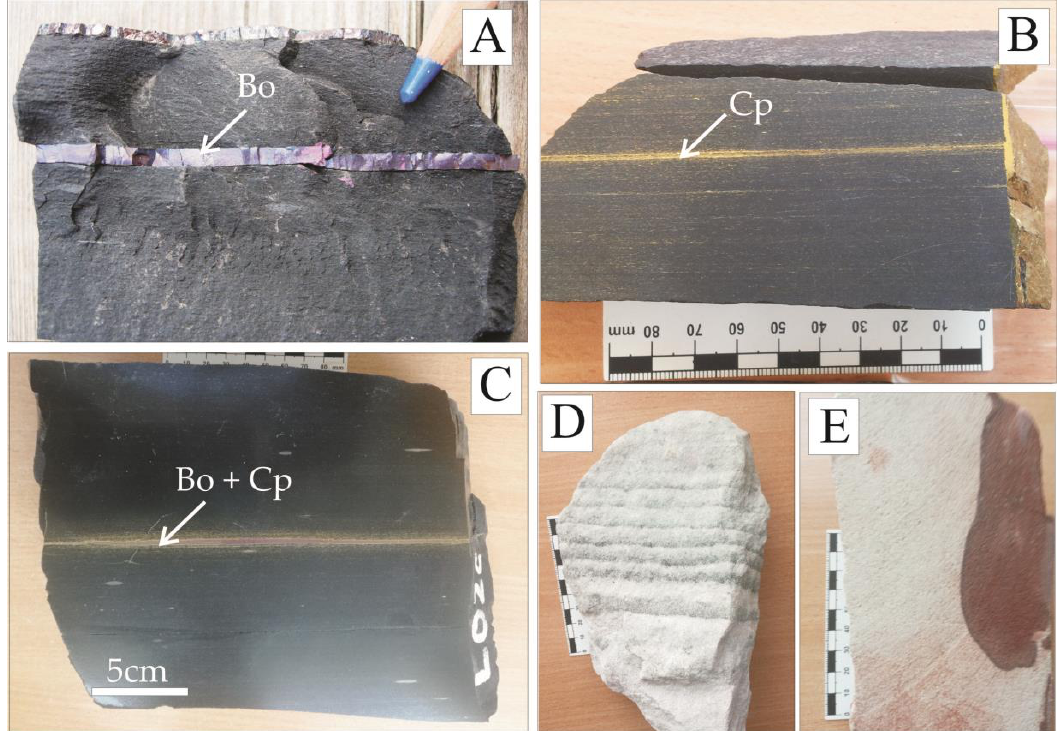
Figure 8. ( A – C ) Typical black shale (Kupferschiefer) ore with bornite (Bo) and chalcopyrite (Cp) veinlet and dissemination, ( D ) Weissliegend sandstone with very characteristic chalcocite lamination, and ( E ) red-spotted sandstones (Rote Fäule). All samples from the Lubin mine.